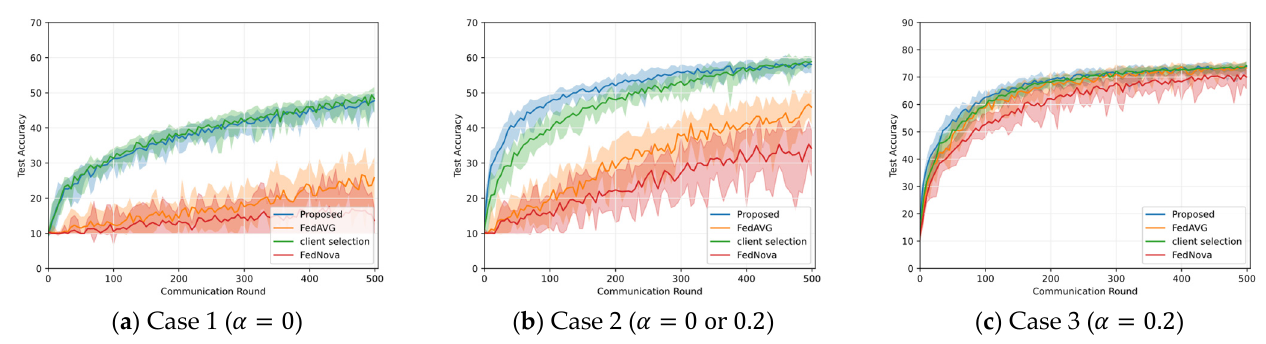
Figure 4. Accuracy comparison among the proposed algorithm, ‘client selection’, and two baseline algorithms on different non-IID situations.